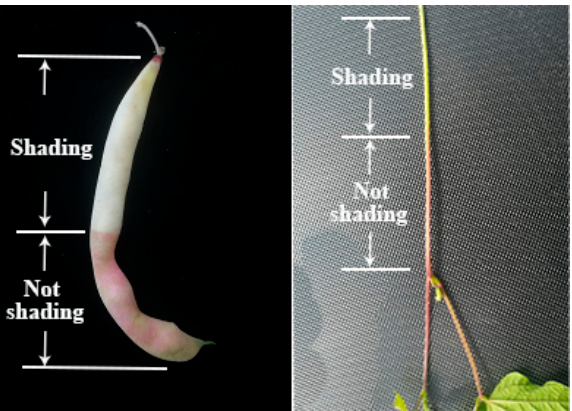
Figure 9. Pod and stem phenotype of ‘ pv-pur ’ after shading treatment.